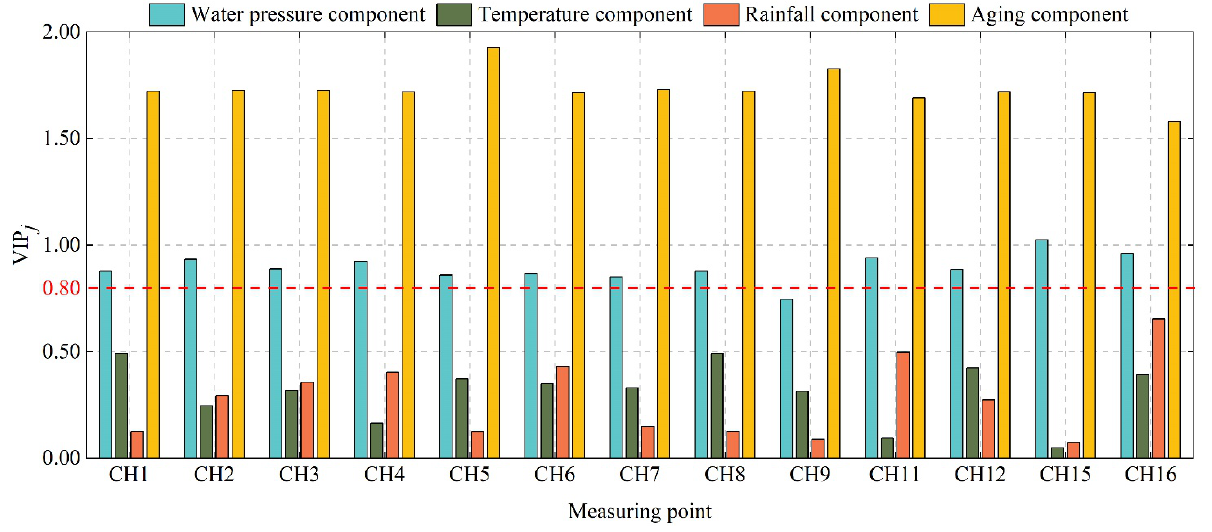
Figure 14. Results of the variable importance for projection of horizontal deformation at profile 0+240 m.